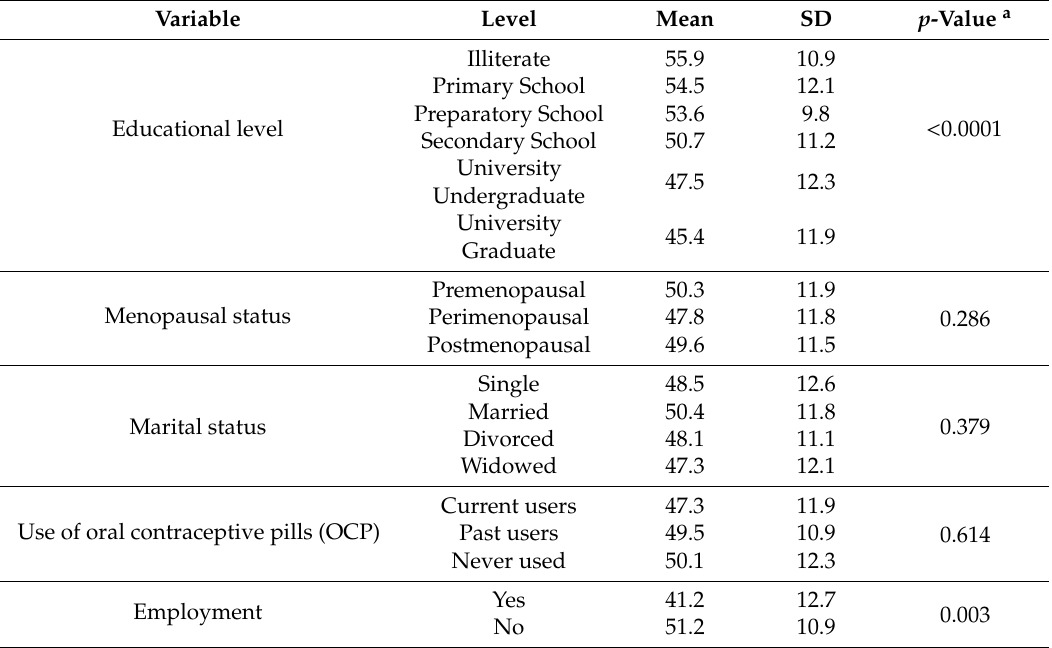
Table 4. Knowledge percentage by independent variables (N = 497).